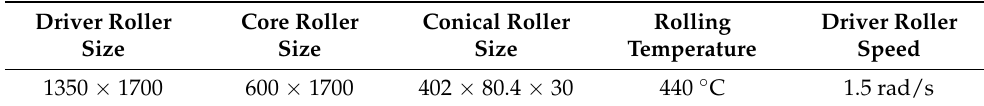
Figure 2. Time vs. speed of core roller.